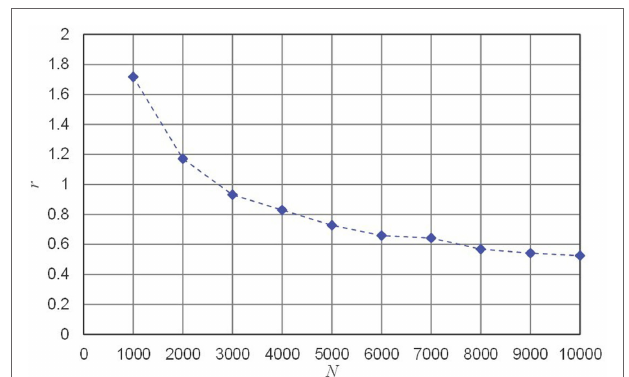
FIGURE 9 | 90% Bayesian credible intervals of life expectancies.